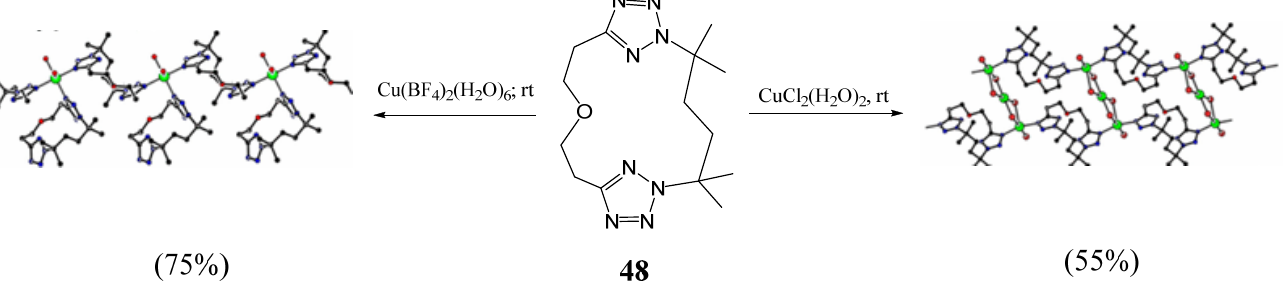
Figure 15. Elaboration of macrocycles 48 and 49 (Reprinted with permission from ref. [30]. Copyright 2012 Elsevier).